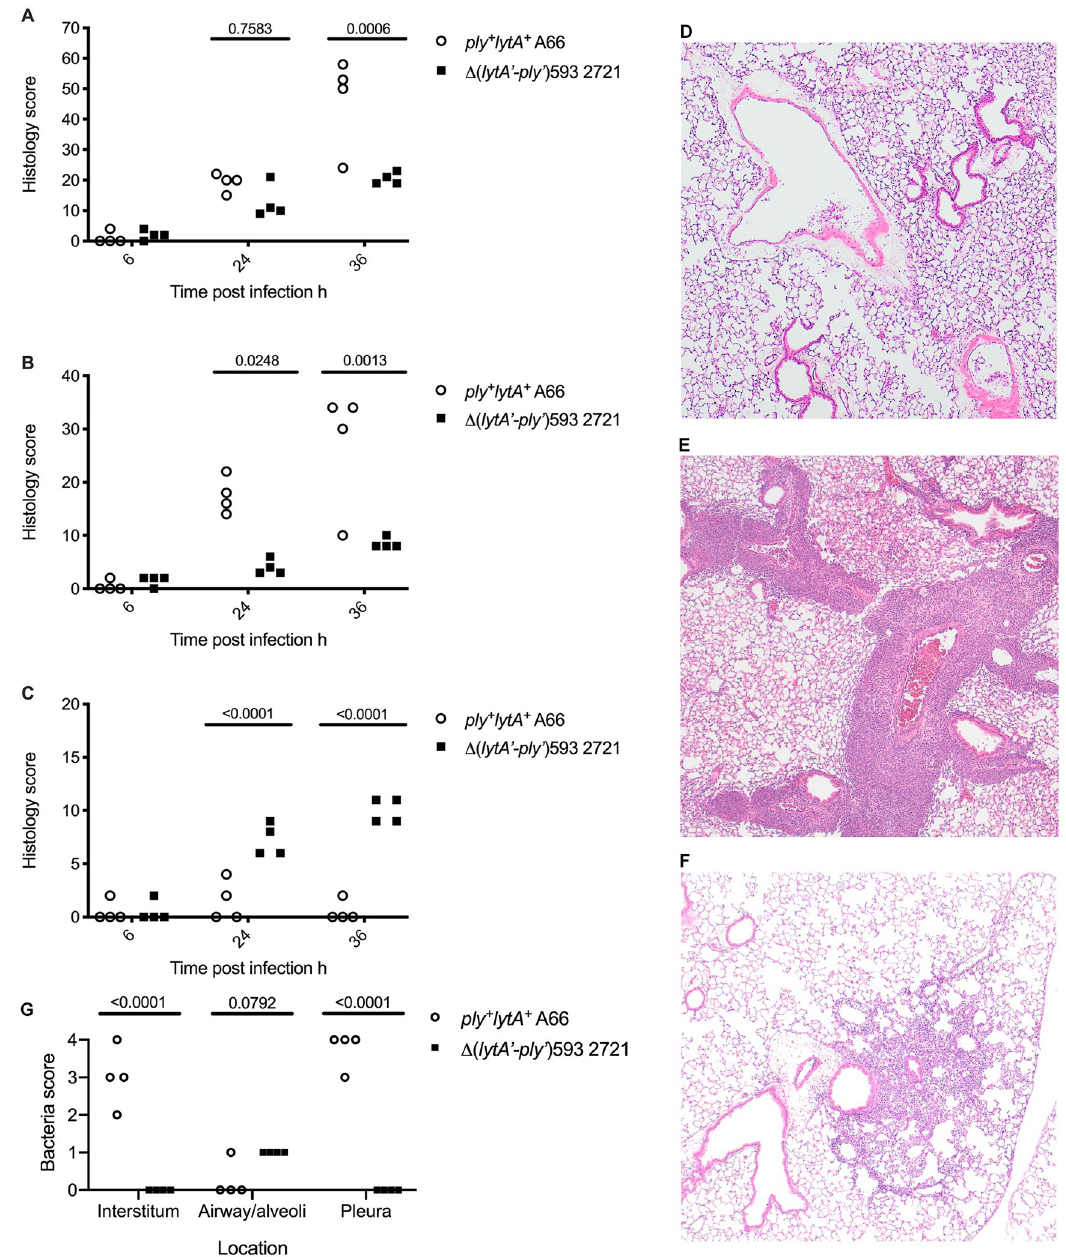
Fig 5. Infection of mice with the Δ ( lytA’-ply’ )593 strain, 2721, induces less severe and spatially distinct pathology to infection with ply + lytA + strain, A66. Wild type C57Bl/6 mouse intranasally inoculated with 3 x 10 4 CFU/mouse of A66 or 8 x 10 4 2721 CFU/ mouse. Whole lungs were fixed and embedded in paraffin at the time points indicated, and haematoxylin and eosin (H&E)-stained sections assessed for pathology using a semi-quantitative histology score assessing inflammation, necrosis and oedema within the airways, interstitium and pleura. The overall histology score included all lung tissues (airways, interstitium and pleura) (A). The histology score of the interstitial tissues (B). The histology score of the air spaces (alveolar spaces/airways) (C). Representative micrograph of PBS-treated control, H&E stain magnification x20 (D). Representative micrograph of ply + lytA + strain A66-induced pulmonary inflammation, H&E stain magnification x20, demonstrating marked interstitial inflammation (E). Representative micrograph of Δ ( lytA’-ply’ )593 strain 2721-induced pulmonary inflammation, H&E stain magnification x20, demonstrating localised intra-alveolar inflammation (F). Semiquantitative histology score representing mean bacterial numbers per 928 μ m 2 (single x640 F22 field of view) within the interstitial tissues, alveolar spaces/airways and pleura (G). Data analysed with two-way ANOVA and a Tukey’s (A) or a Sidak’s (B,C,G) multiple comparison test. Adjusted P-values reported.